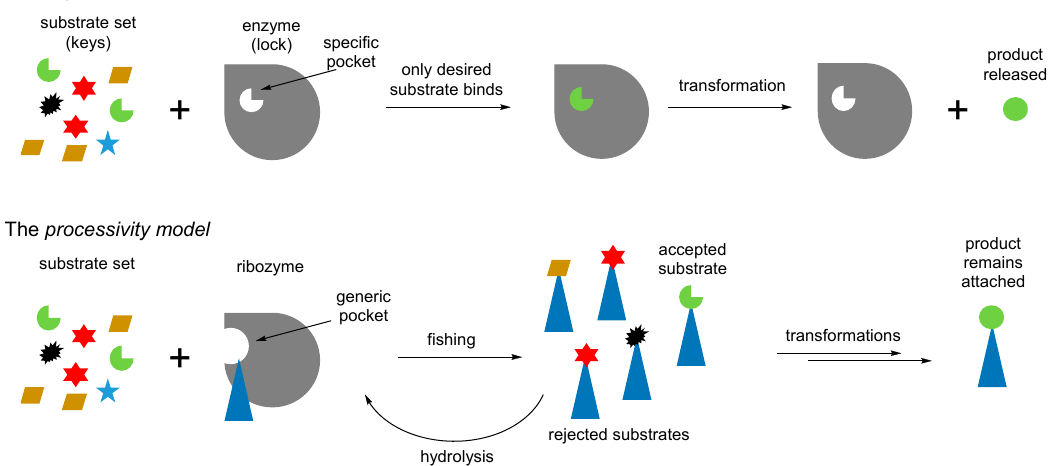
Figure 9. The key-lock model of enzyme chemistry versus the processivity model, which is likely to occur with the RNA mediated chemistry. The processivity model views the ribozyme as the Maxwell’s demon, a hypothetical creature that makes a system more complex through filtering. Many biological mechanisms operate this way [73].